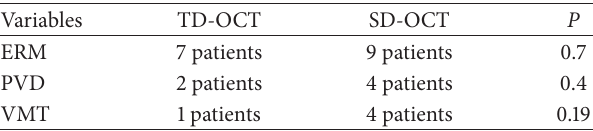
Table 2: The ability of spectral-domain optical coherence tomogra- phy and time-domain optical coherence tomography to detect the vitreoretinal surface